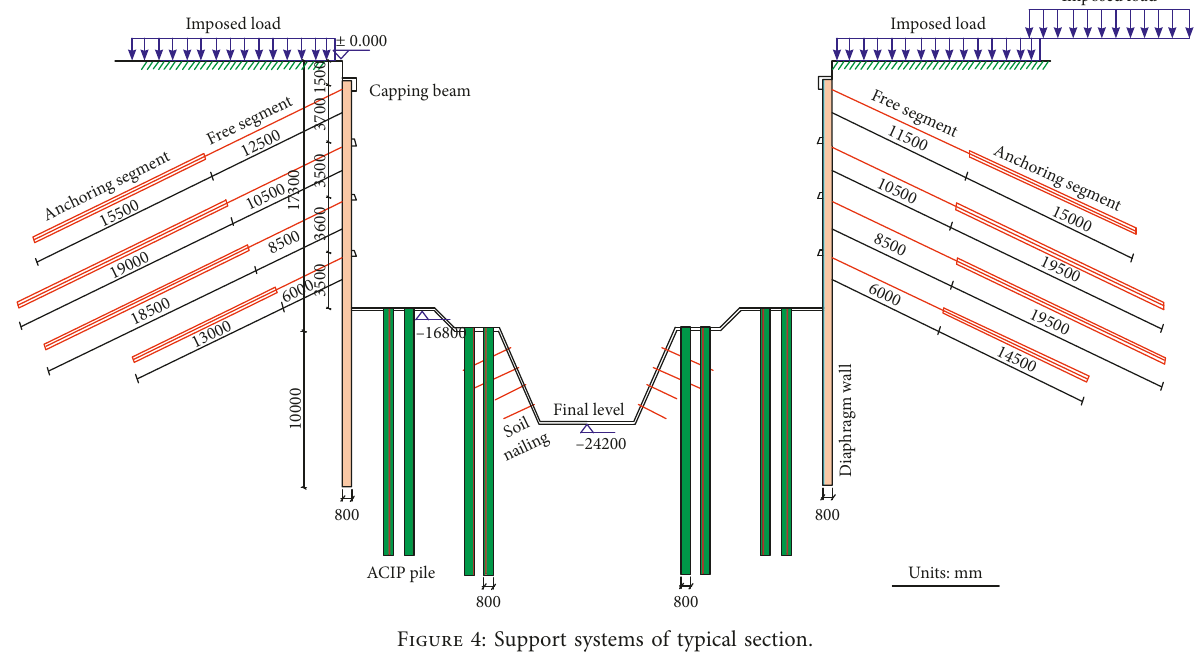
Figure 4: Support systems of typical